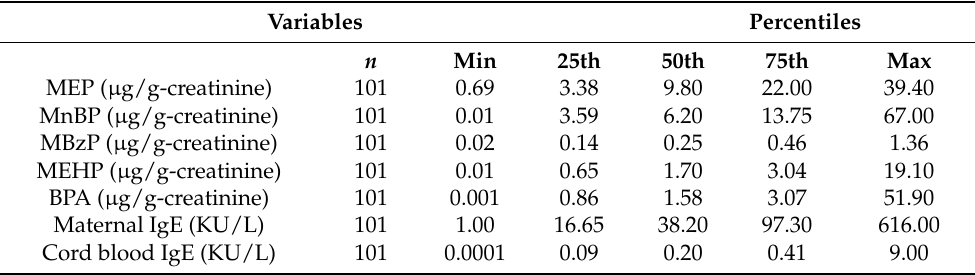
Table 2. Distribution of maternal urinary phthalate metabolites, and the maternal and corresponding newborn cord blood IgE